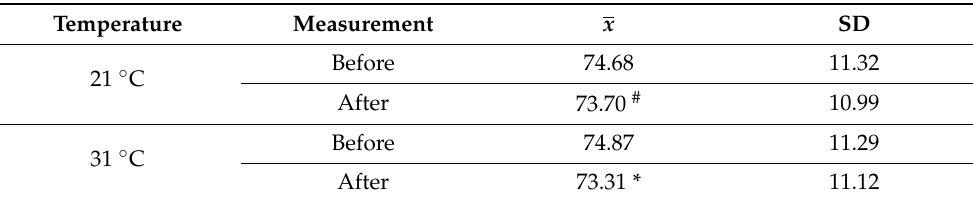
Table 3. Mean and standard deviation of body mass (BM kg) at 2 temperatures in individual measurements before and after the series of pulsating efforts.